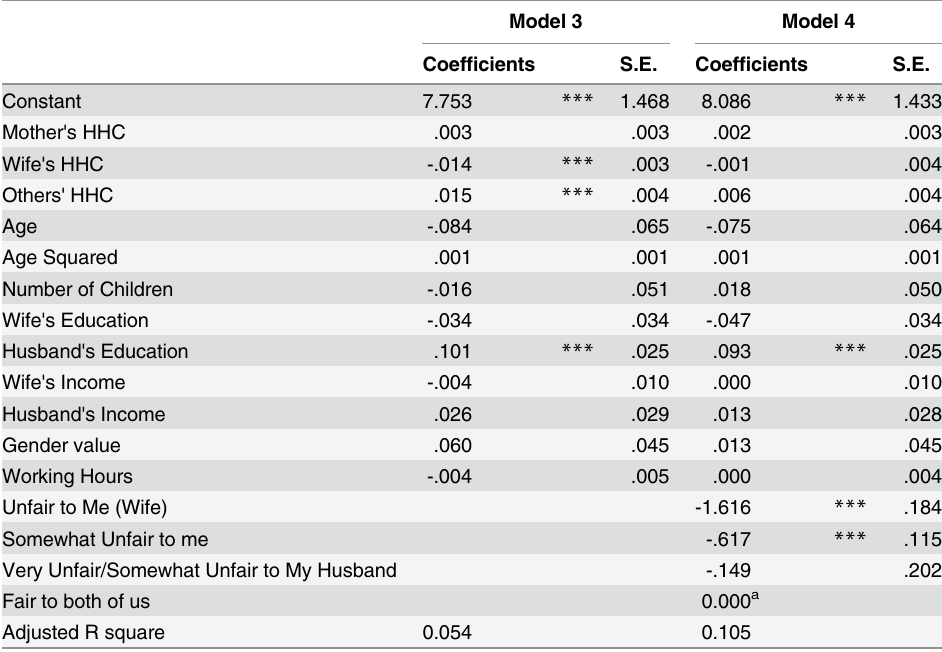
Table 5. Determinants of Sense of